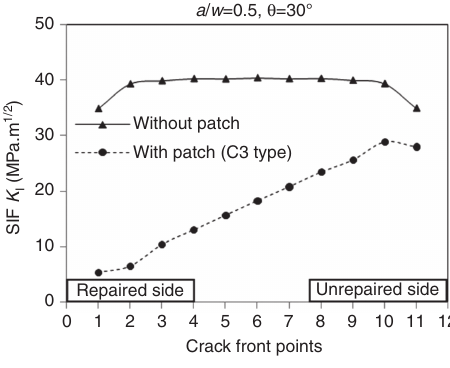
Figure 21 Effect of patch on K